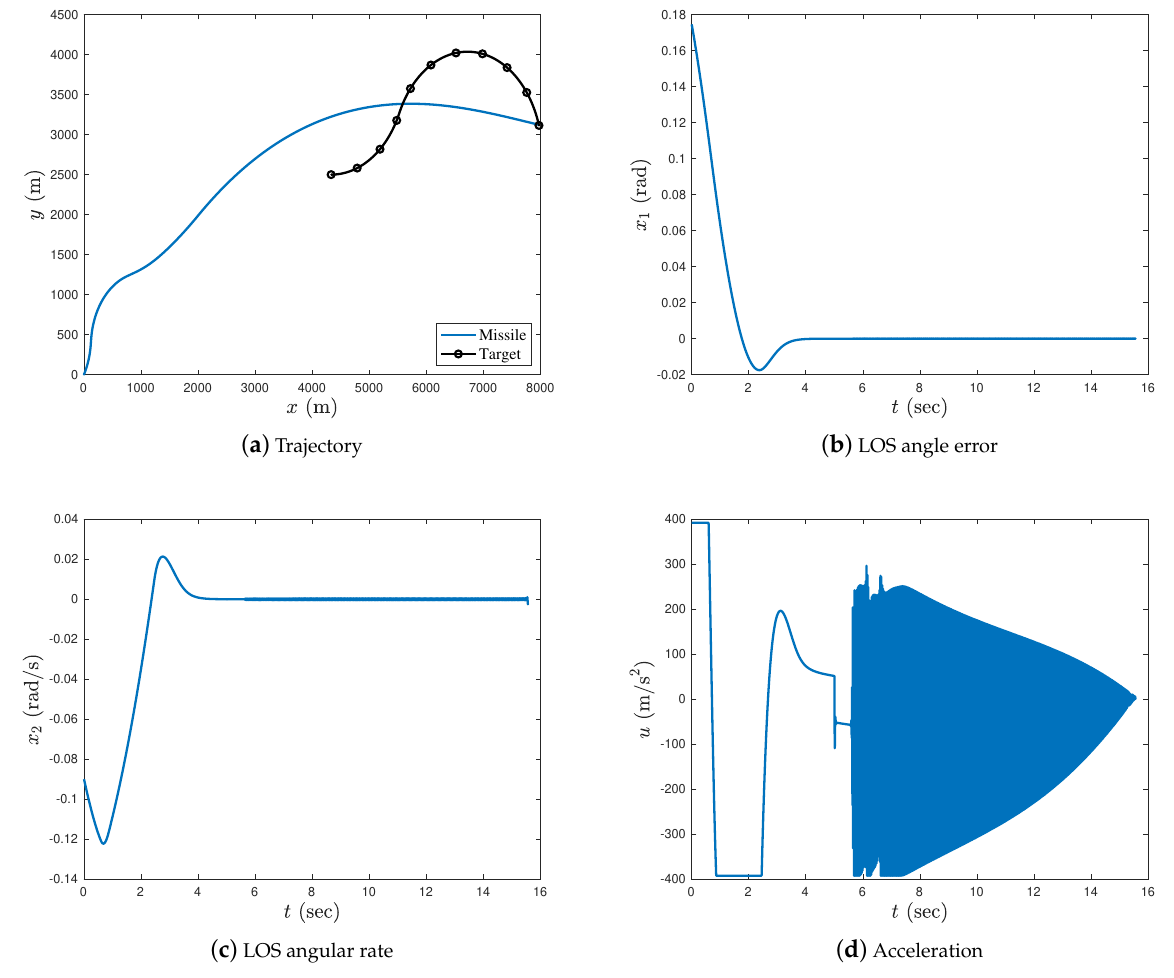
Figure 7. Simulation results with α = 0 in case 2.